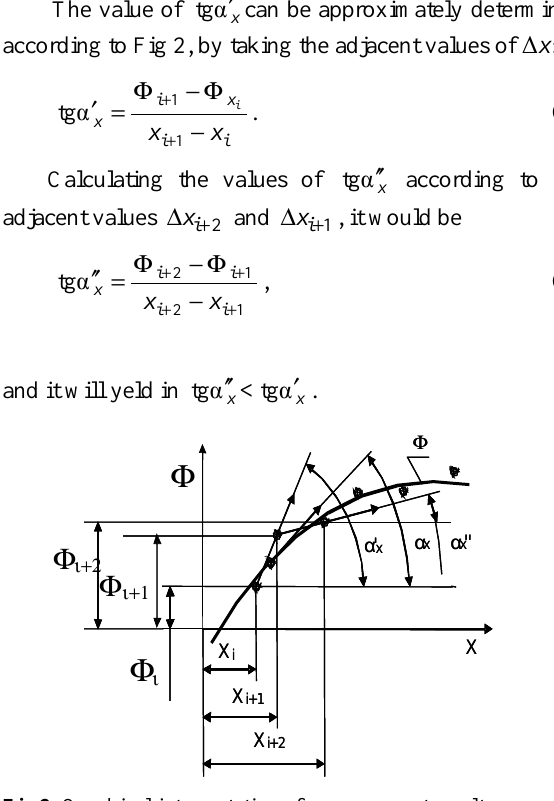
Fig 2 . Graphical interpretation of measurement